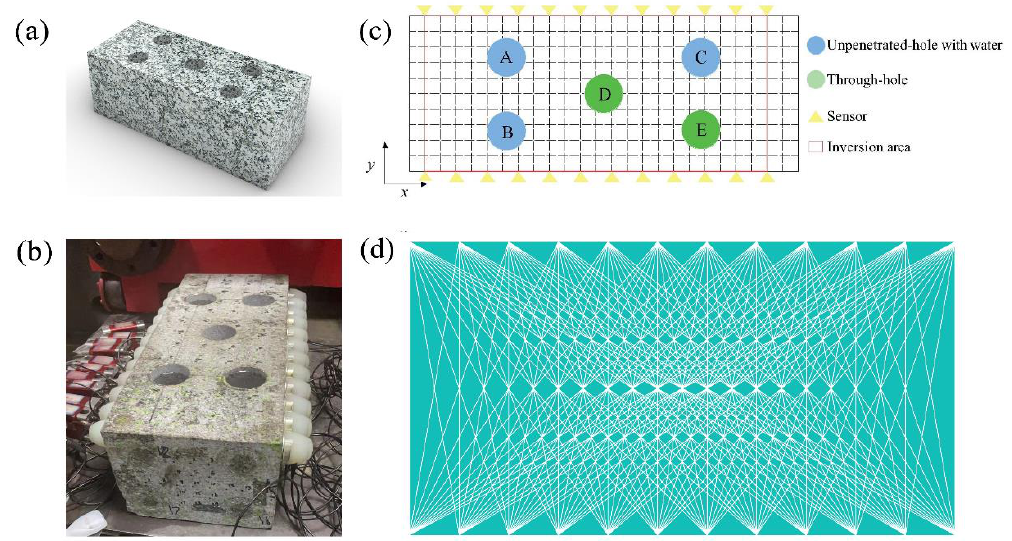
Figure 8. Experimental environment and settings. ( a ) Three-dimensional hole-containing granite medium model. ( b ) Acoustic monitoring experiment diagram. ( c ) Two-dimensional schematic diagram of experimental settings. ( d ) Ray coverage; the white lines represent the assumed ray paths.